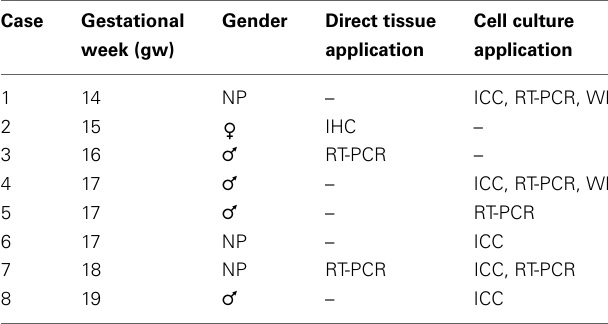
Table 1 | Fetal human brain tissue used in this